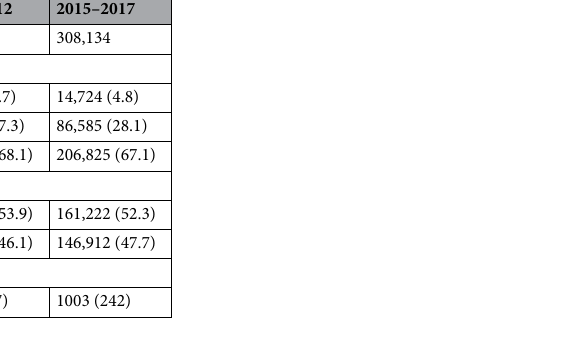
Table 1. Population